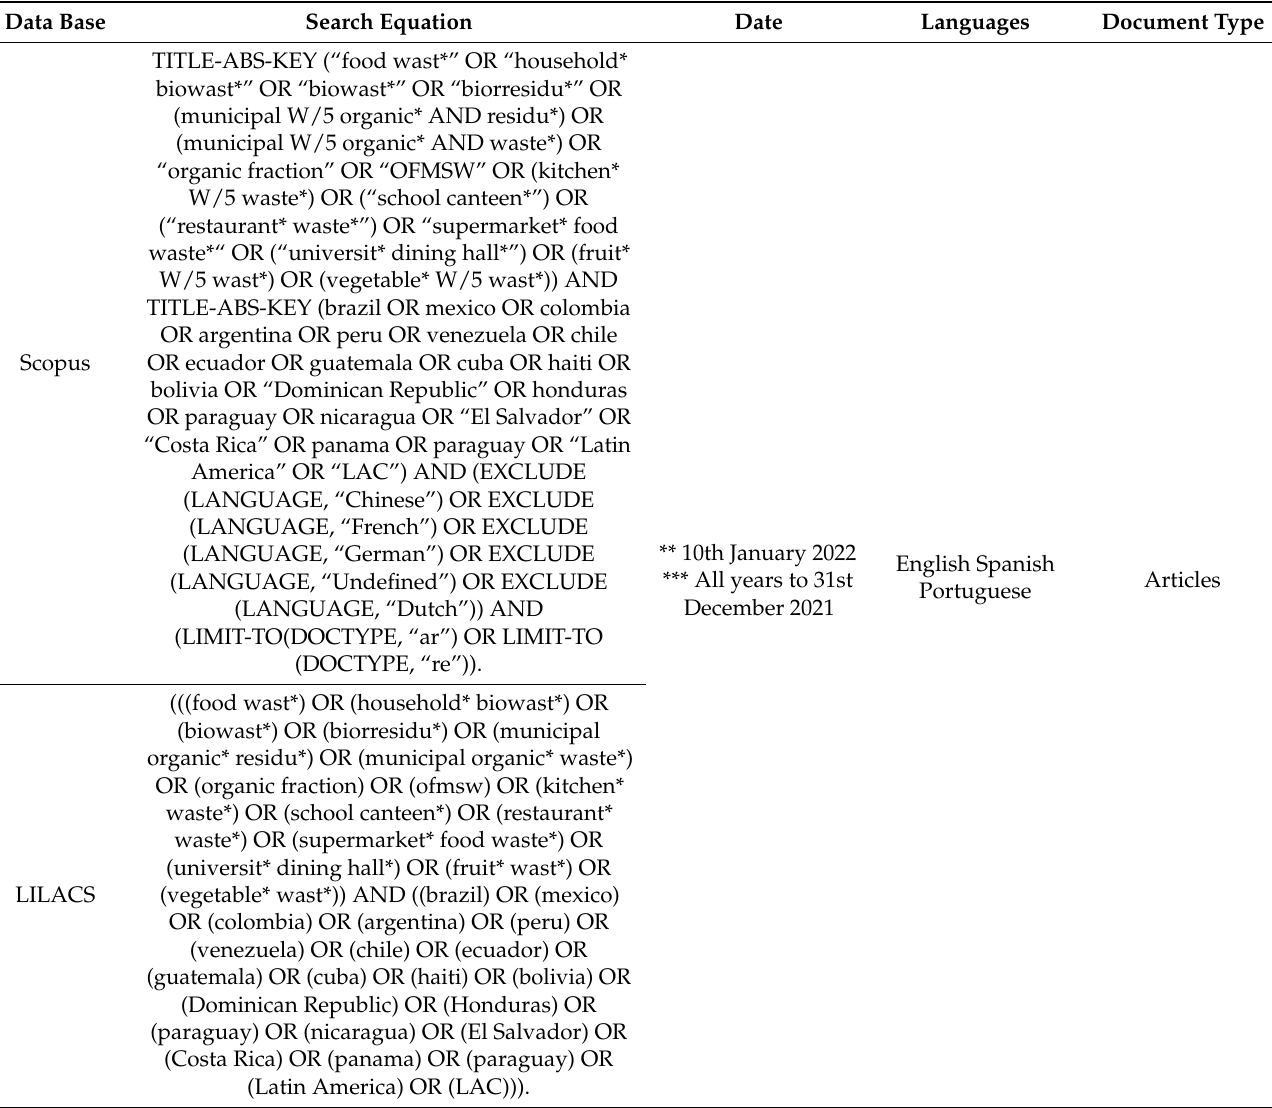
Table 1. Main search